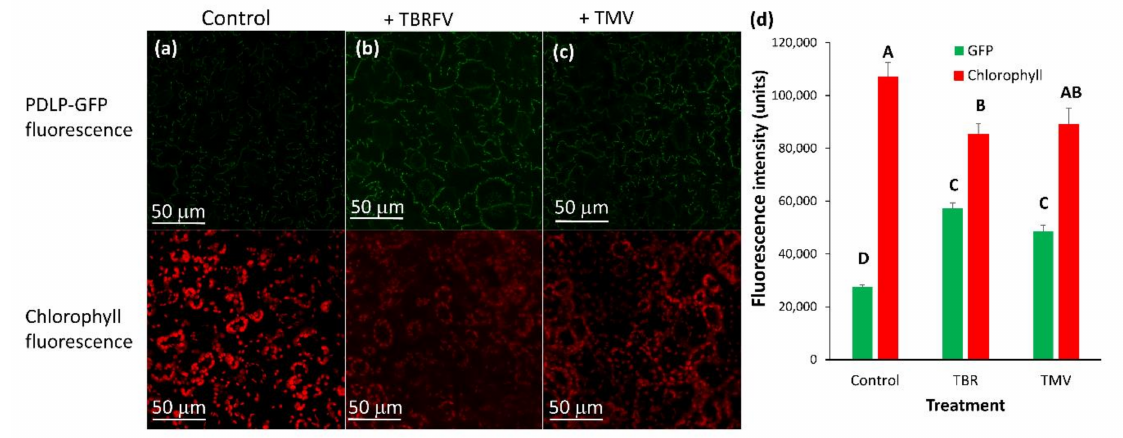
Figure 8. Fluorescence intensity of PDLP5-GFP protein in epidermis cells after ToBRFV and TMV infection in leaves of tomato plants (money maker). Tomato plants were stably transformed with 35S::PDLP5-GFP and were viewed in confocal microscopy 30 days after inoculation with ToBRFV (TBR) or TMV (TMV) or mock-inoculated ( control ). ( a – c ) pictures show GFP and chlorophyll fluorescence in various cell types; ( d ) fluorescence area of GFP or chlorophyll per µ m of the cell wall was measured per treatment. Means ( ± SE) are shown. Different letters above the data columns mean that differences between treatments are statistically significant ( p {f} < 0.001) in the parameter